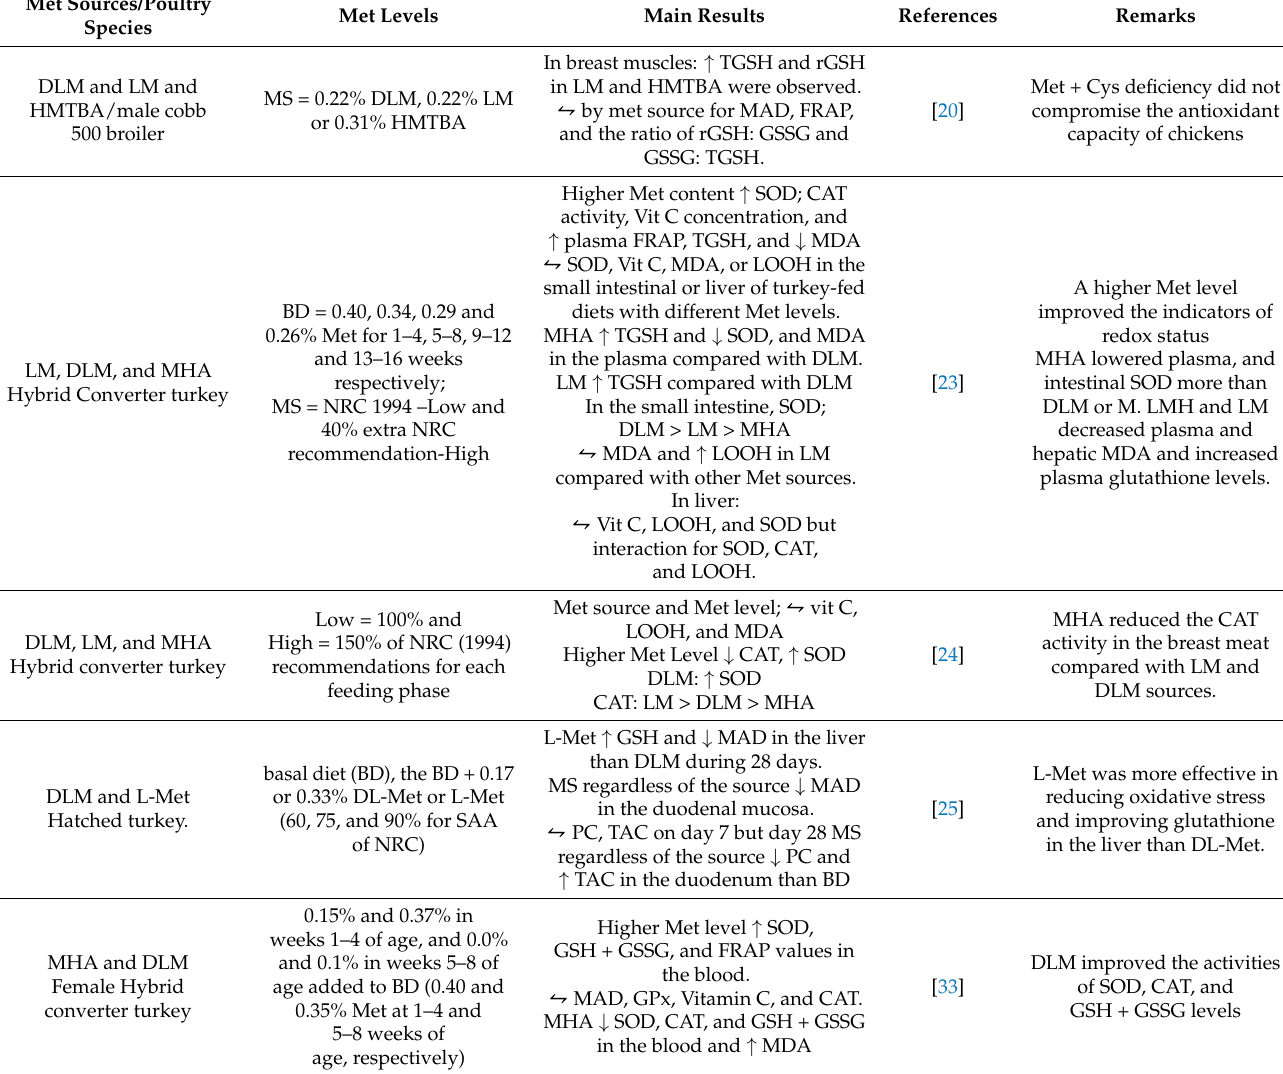
In breast muscles: ↑ TGSH and rGSH in LM and HMTBA were